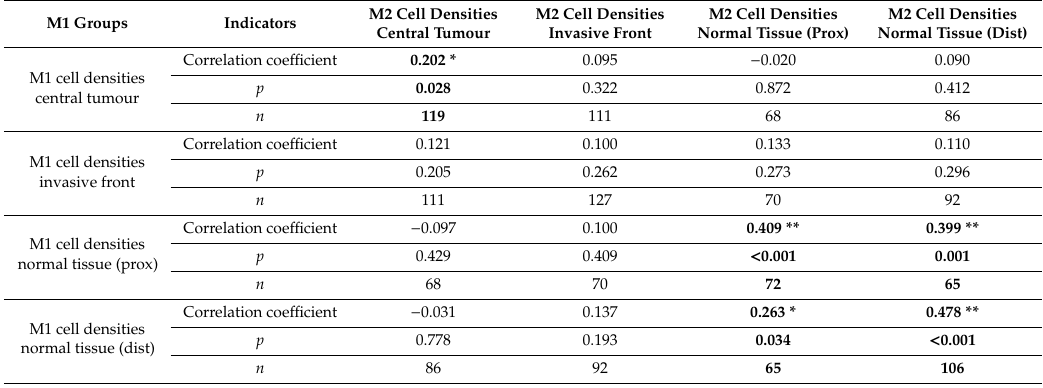
Table 2. Correlations between macrophage phenotypes in different tumour compartments.